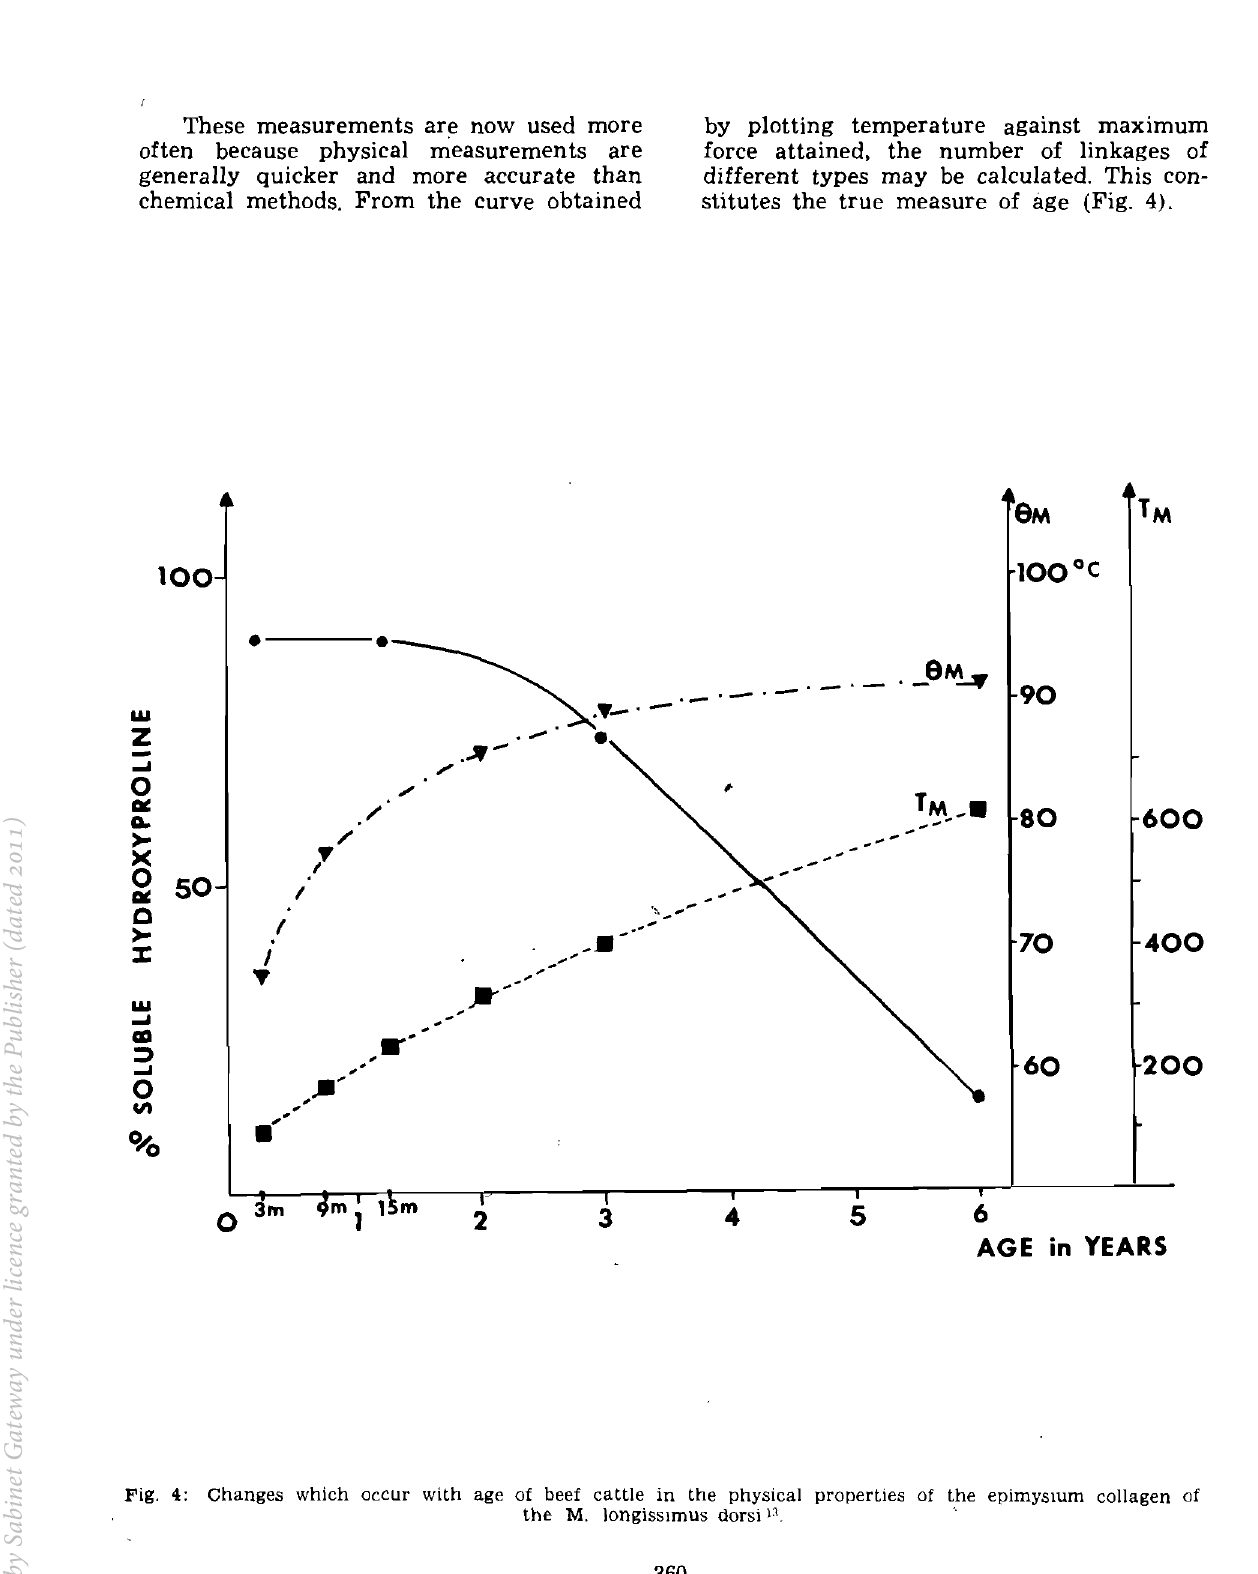
Fig. 4: Changes which occur with age of beef cattle in the physical properties of the epimysIUm collagen of the M. longissImus dorsi 1'.